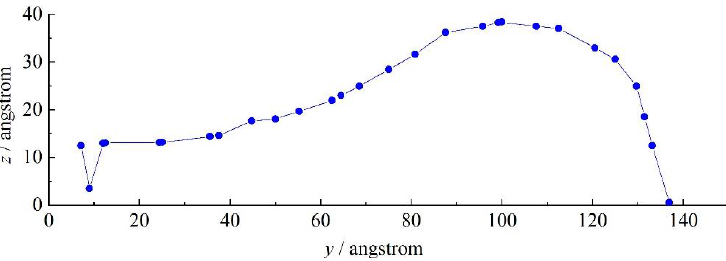
Figure 15. Contour of nitrogen jet (7.5 MPa, 120 K) sprayed into supercritical argon environment (5.5 MPa, 200 K) at t = t 0 + 100 ps. Molecules 2018 , 23 , x FOR PEER REVIEW